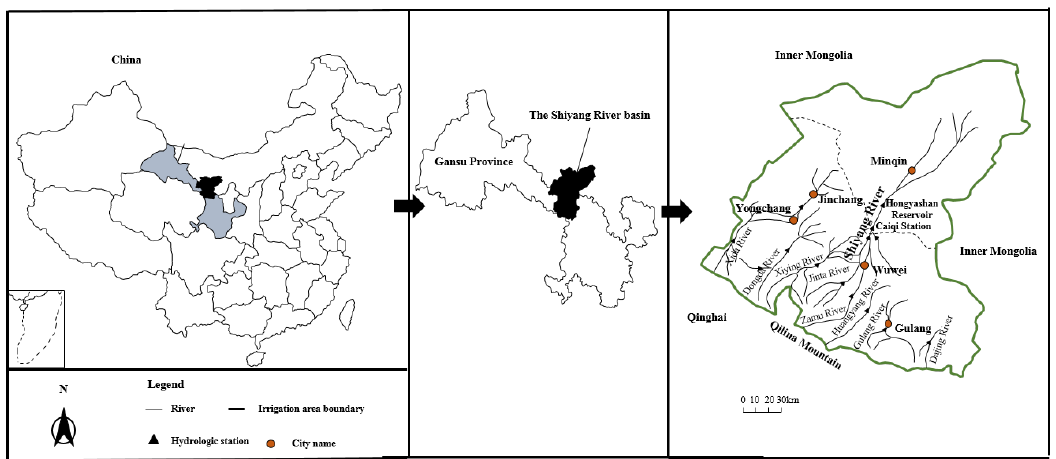
Figure 2. Sketch map of the Minqin Oasis in northwest China